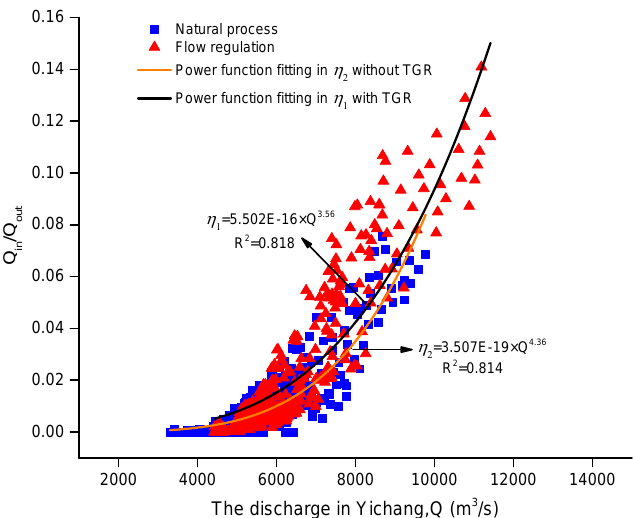
Figure 9. Relationship between the coefficient of water exchange and the outflow discharge of the TGR during the dry seasons (December to the following April) from 2008 to 2011. η 1 and η 2 denote the coefficients of water exchange with and without the TGR.